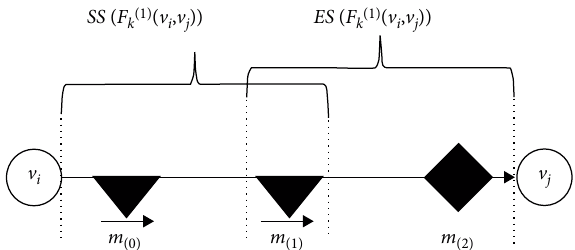
-th SNDF original 𝑘